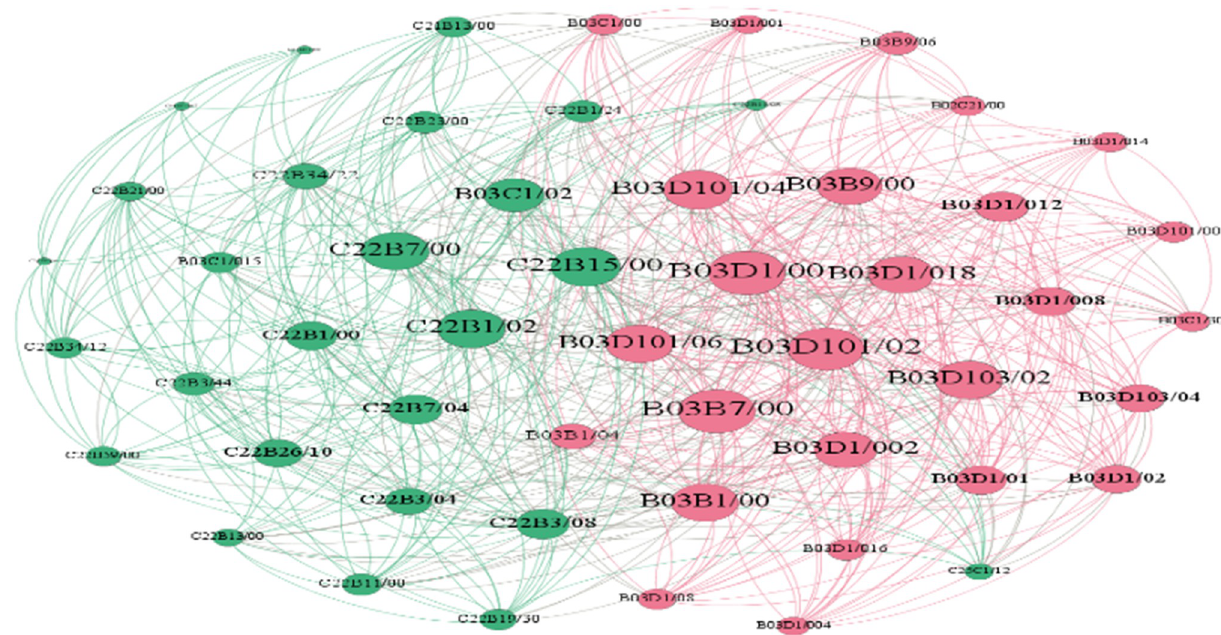
Fig 7. IPC association network diagram.